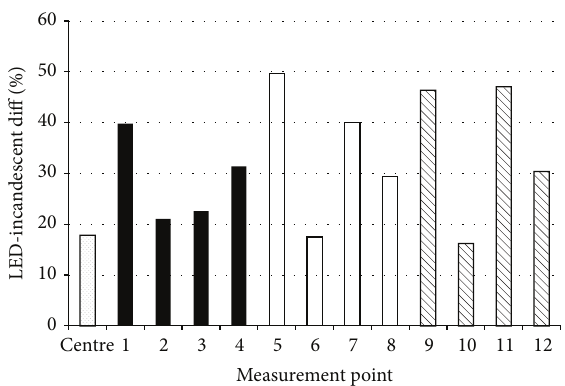
Figure 7: Percentage illuminance difference on the Fresnel lens between incandescent lamp and LED